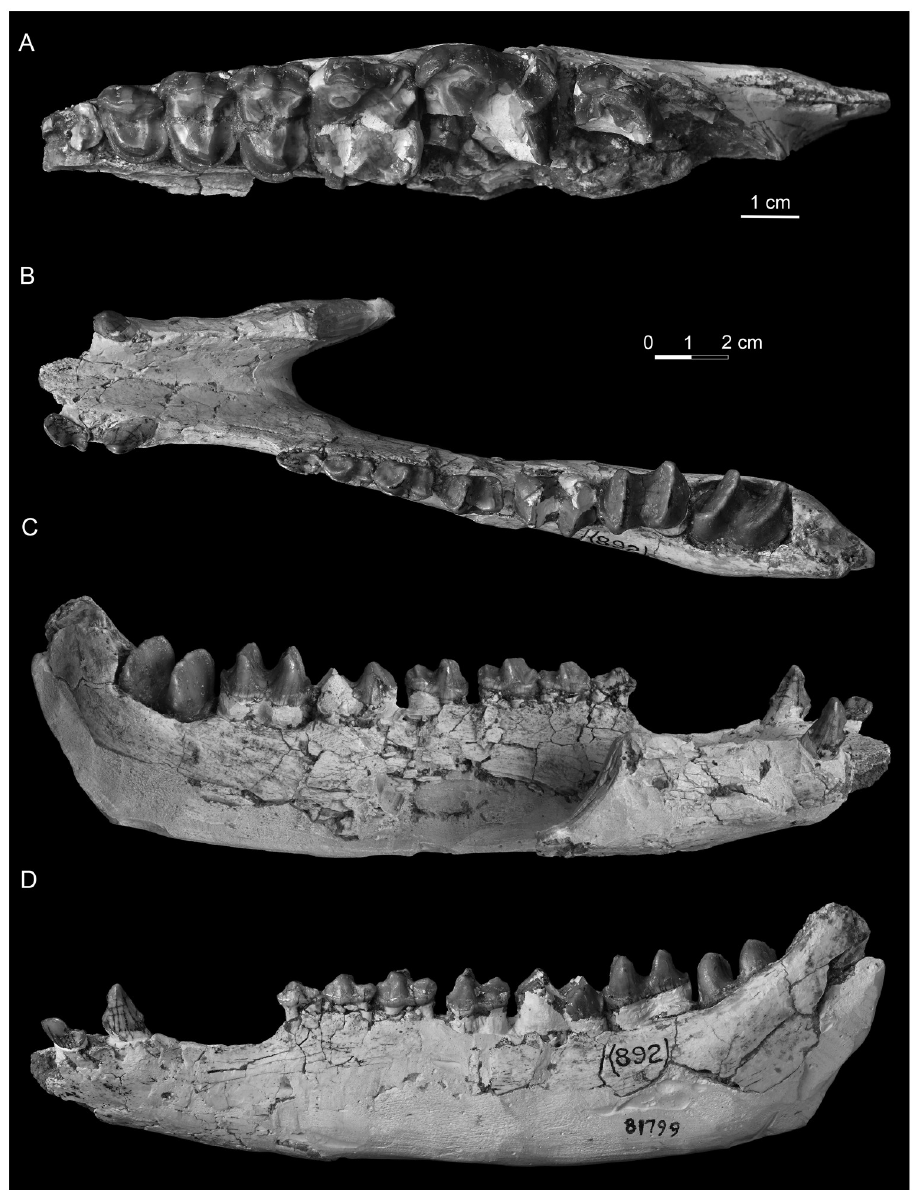
Fig 4. Upper cheek teeth and lower jaw of deperetellid Irenolophus primarius from the Arshanto Formation at Huheboerhe of the Erlian Basin, Inner Mongolia, China. (A) occlusal view of the left maxilla with P2-M1, and M2–3 fragments (AMNH FM 81851). (B-D) lower jaw with right c, left i3, c, and p1-m3 in occlusal (B), lingual (C), and buccal (D) views (AMNH FM